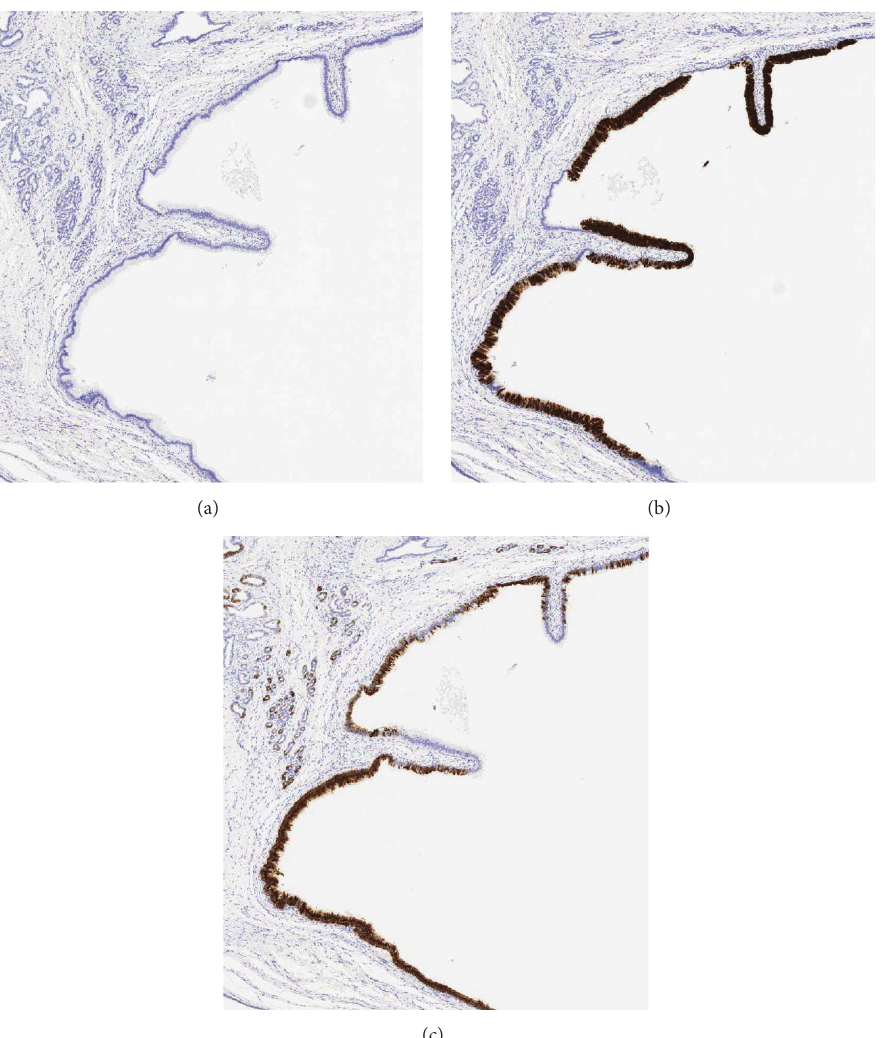
Figure 5: (a) Both the BilIN and background epithelia were negative for MUC2. (b) Only BilIN was positive for MUC5AC. (c) Not only BilIN but also the background epithelia were positive for